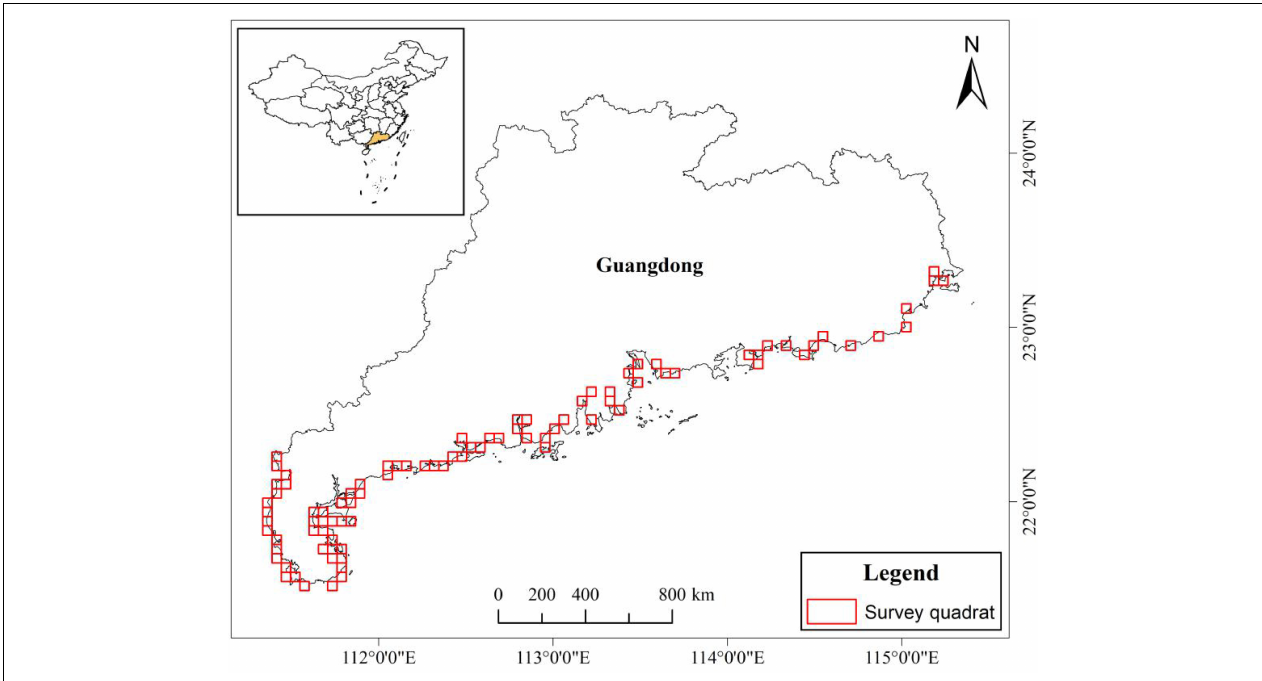
FIGURE 1 | Schematic diagram of Guangdong Province, China, showing locations of 87 coastal quadrat sampling survey points.